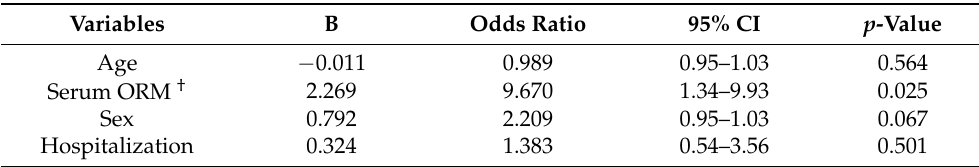
Table 4. Binary logistic regression analysis for variables independently associated with fatigue on follow-up visit in patients with long-COVID syndrome.